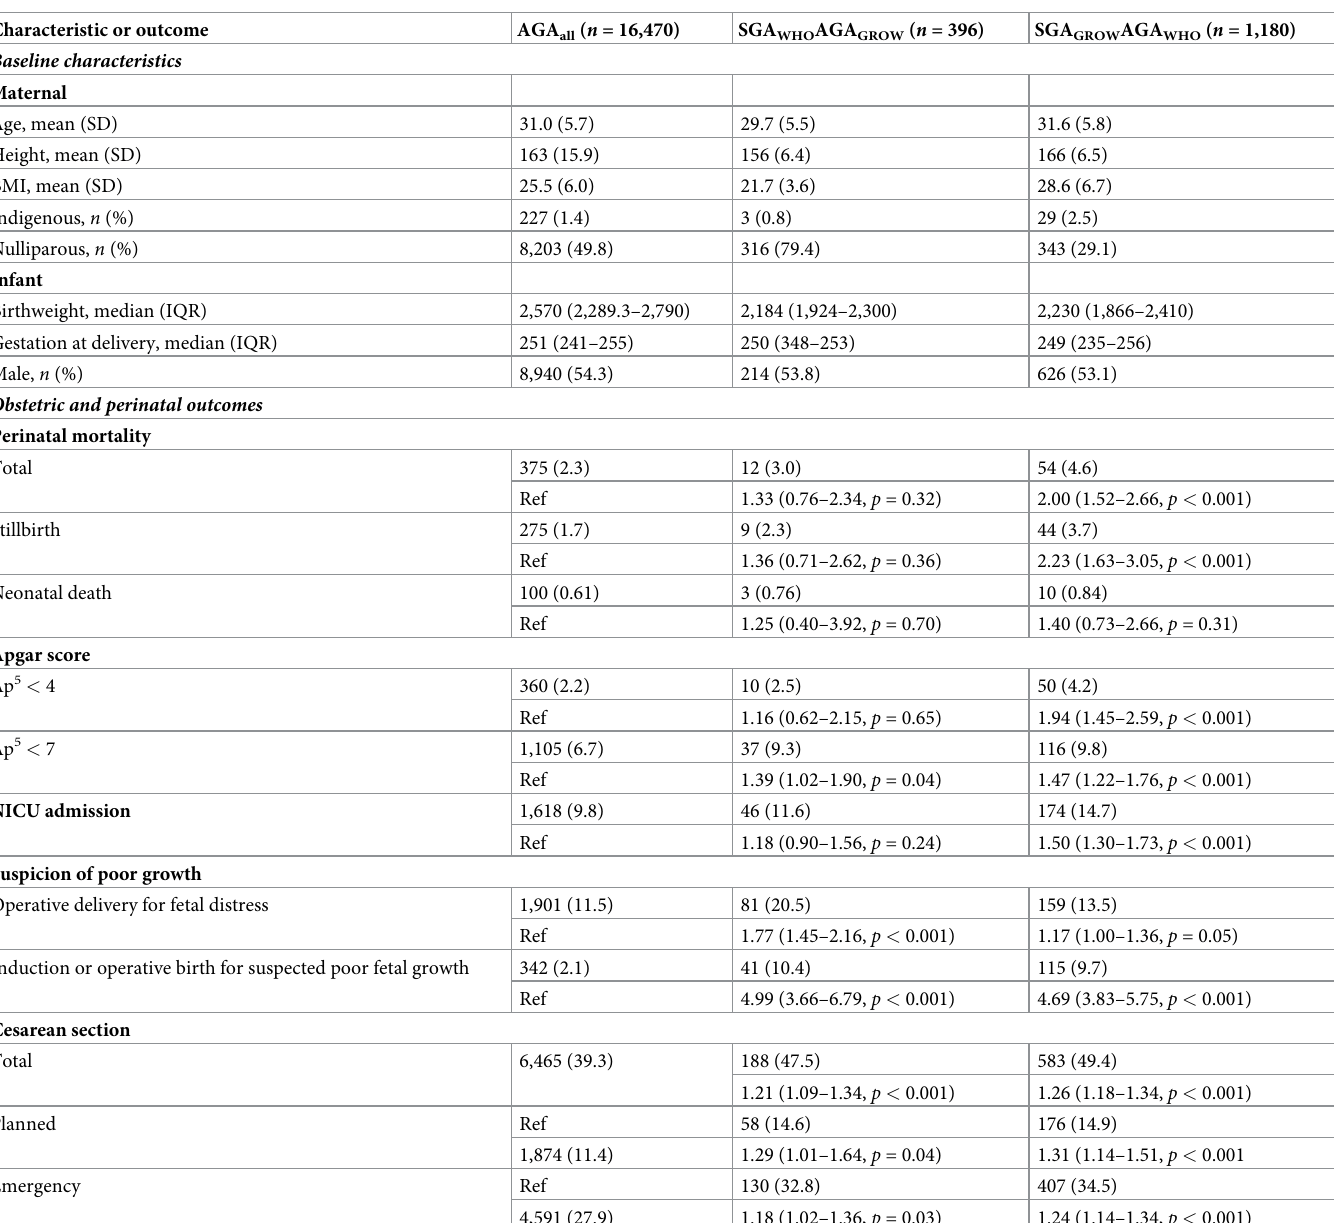
Table 3. Baseline characteristics and perinatal outcomes for non-overlapping populations classified as small for gestational age by WHO fetal charts or GROW charts. Characteristic or